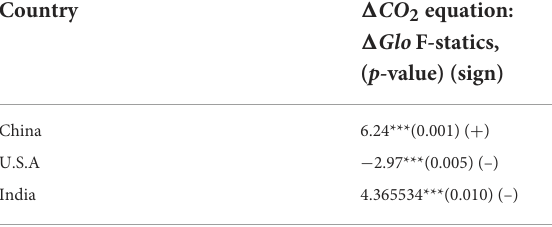
TABLE 5 The results in granger causality in short term.